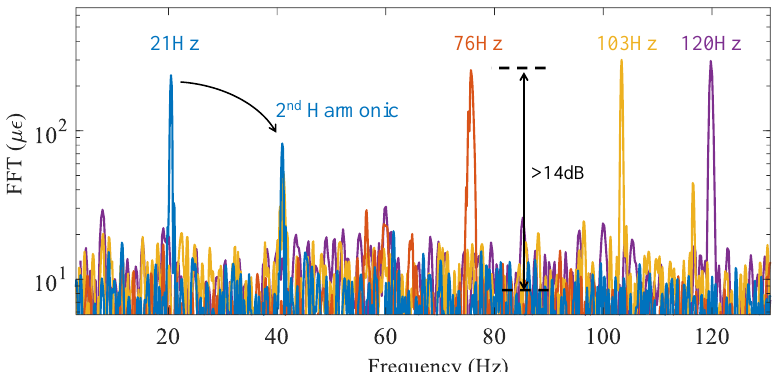
Figure 6. Frequency spectra of the sensor excited with a strain wave of ∼ 300 µε amplitude at f = 21, 76, 103 and 120 Hz (FFT: Fast Fourier Transform). Signals are averaged 10 times.